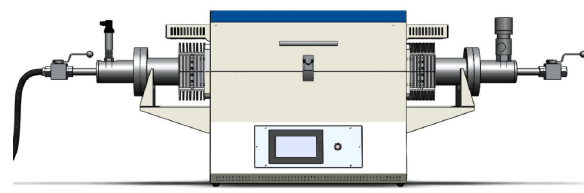
Figure 1. Combustion Chamber Table 1. Specifications of tube furnace